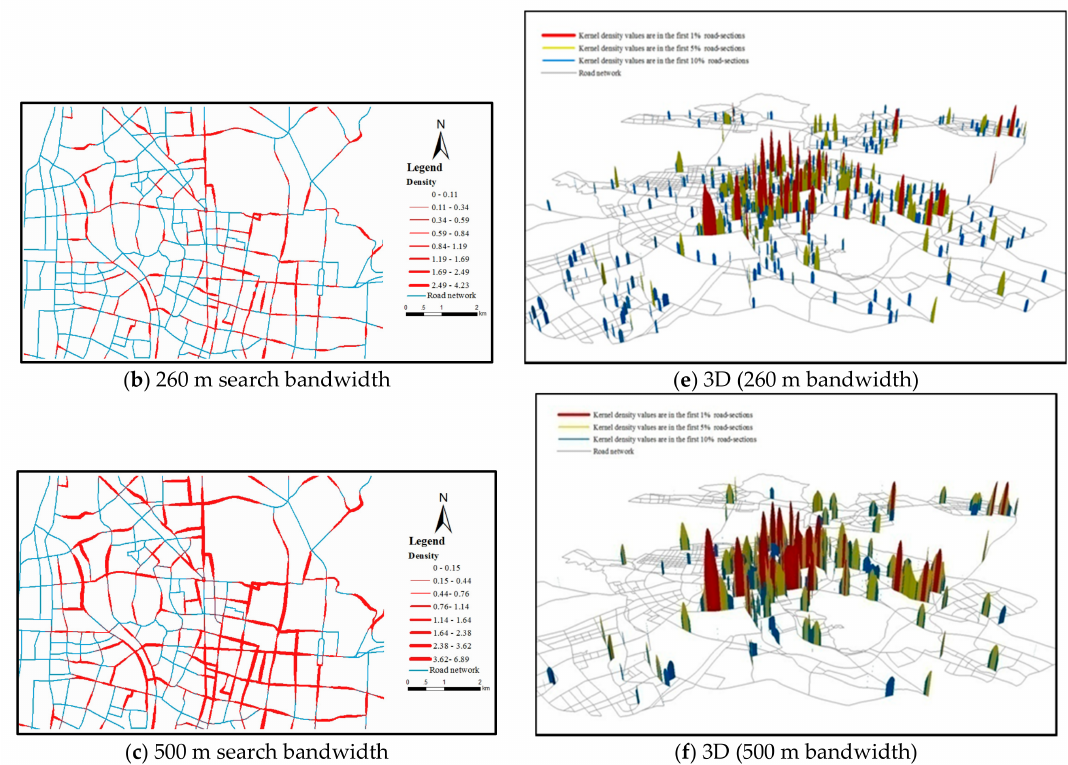
Figure 12. Illustration of the impacts of different search bandwidths on the density pattern: ( a – c ) the results for the search bandwidth of 100 m, 260 m, and 500 m at a local scale, respectively; and ( e – f ) 3D visualization of the spatial pattern of density estimated by the proposed network KDE in the overall